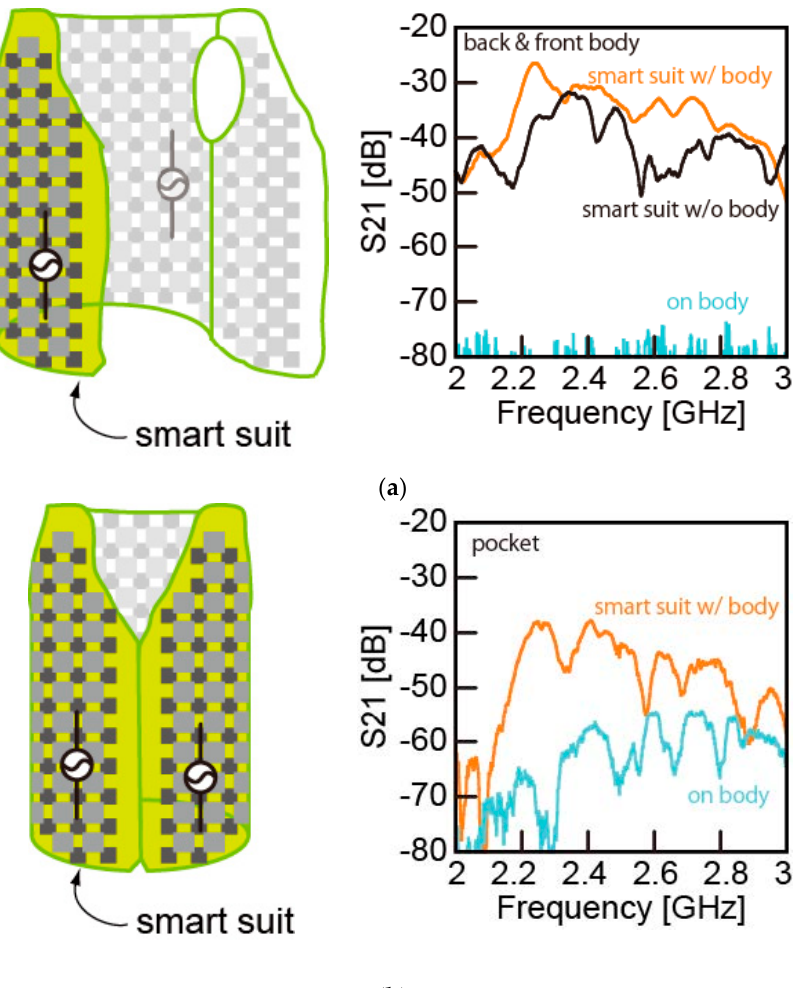
Figure 10. Transmission characteristics of the smart suit. ( a ) Transmission characteristics on the back and front of the human body, ( b ) Transmission characteristics on the front of the human body.